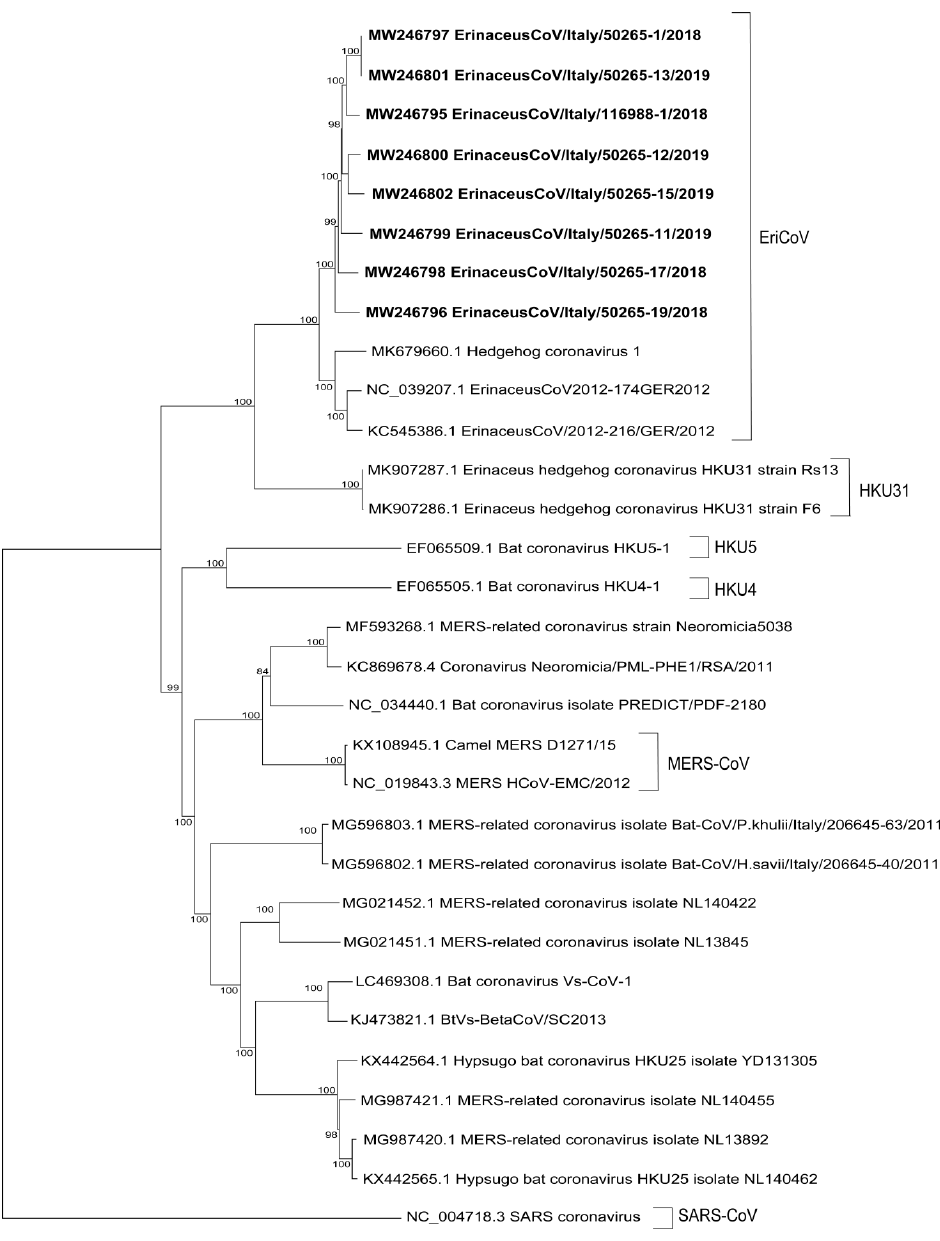
Figure 1. Maximum Likelihood phylogenetic tree of the Merbecovirus subgenus complete genomes including the eight Italian EriCoV strains. The tree was built using the GTR+G+I model and 1000 bootstrap replicates with supported nodes (>70%). The entries are reported as: Accession number and the sequence name.